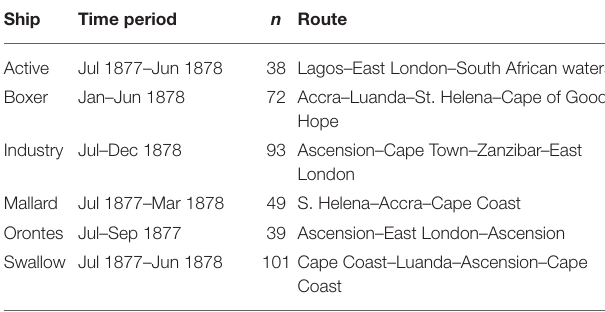
TABLE 2 | Log books digitized for the period 1877/78: ship name, time period covered, number of noon observations assimilated, and route.